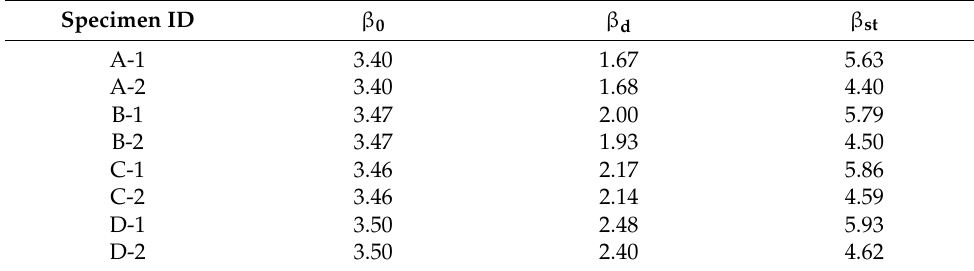
Table 7. Results of computing the reliability index of steel girder.